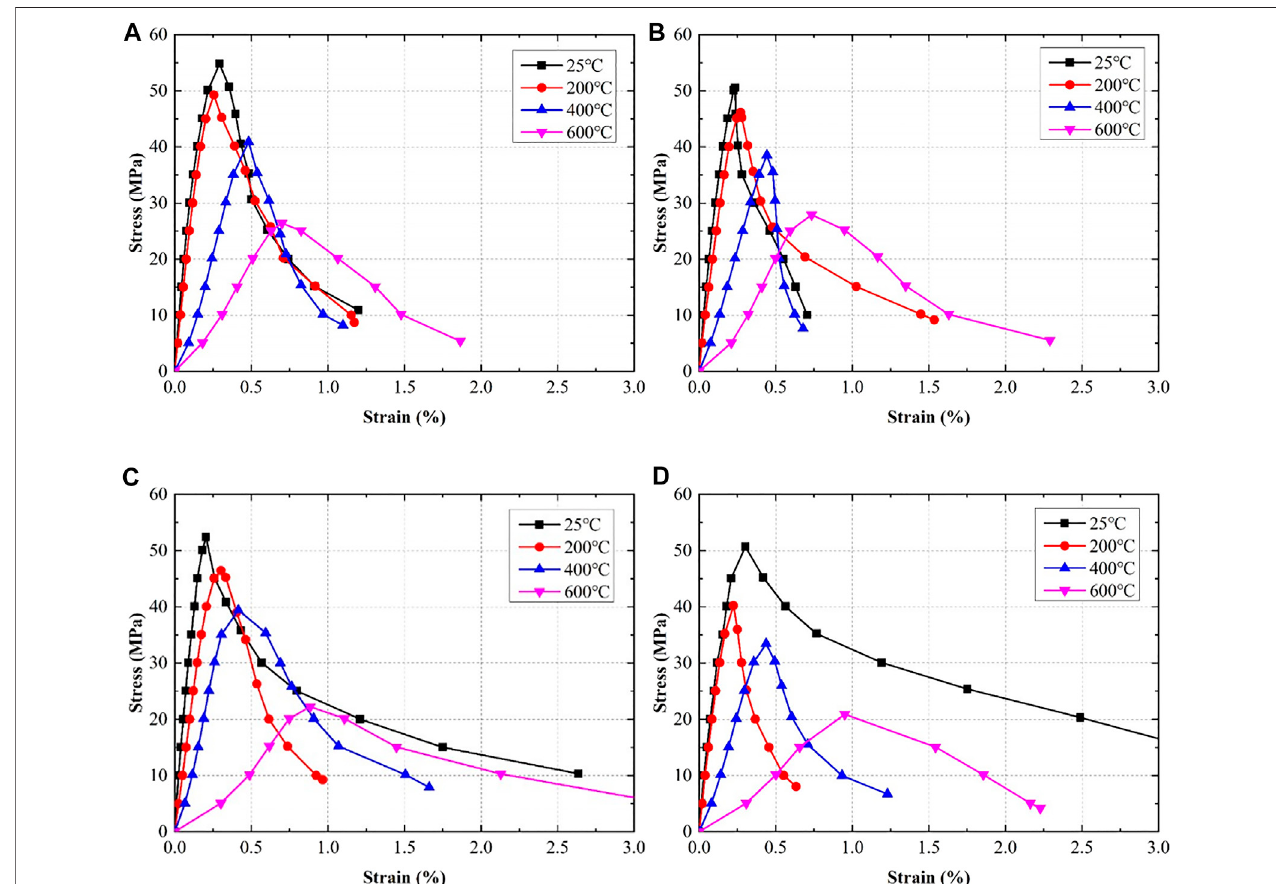
FIGURE 12 | Typical stress − strain of RRAC-A after heating: (A) RAC-A; (B) RRAC-A-5; (C) RRAC-A-10; (D) RRAC-A-15.